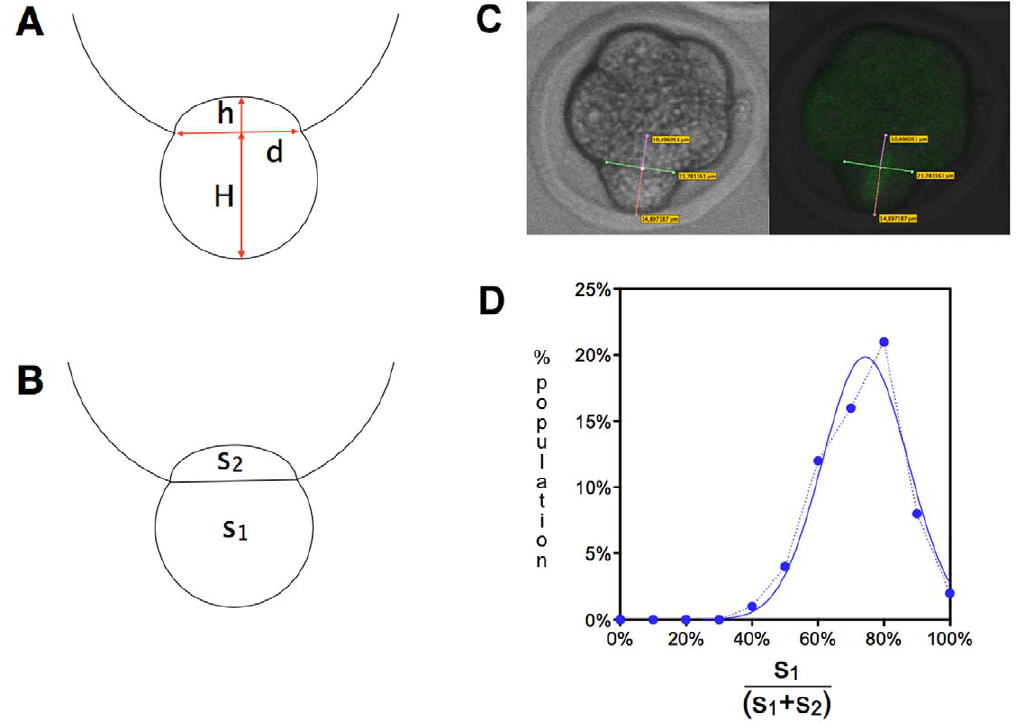
Figure 8. Measurement of blastomere bulging during mitosis. A-C: The measurements (A) required to estimate blastomere bulging were performed on image stacks (C). The surface of S 1 (corresponding to half of an ellipsoid) and S 2 (corresponding to a truncated circle) was then calculated (B). An example is shown in C where both fluorescence and transmitted light images were used. D: Distribution of the «bulging» index. The Y axis corresponds to the percentage of blastomeres with a given bulging index (X axis).